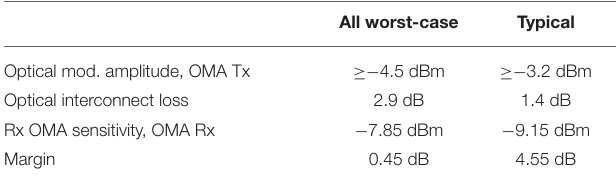
TABLE 3 | On-off keying 25 Gb/s optical link budget.